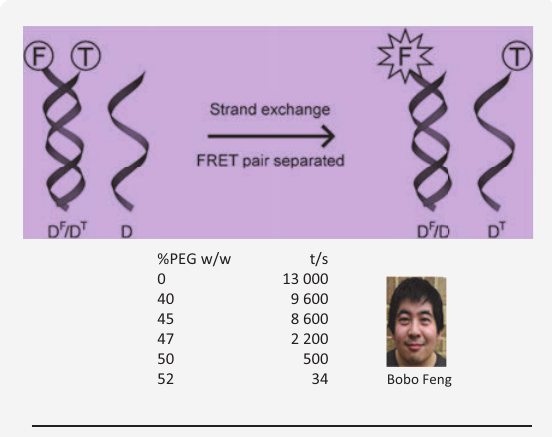
Figure 9. Spontaneous DNA strand exchange catalyzed by poly(ethylene glycol) (PEG) 33 . Figure adapted from results in Ref. 33 by Dr Bobo